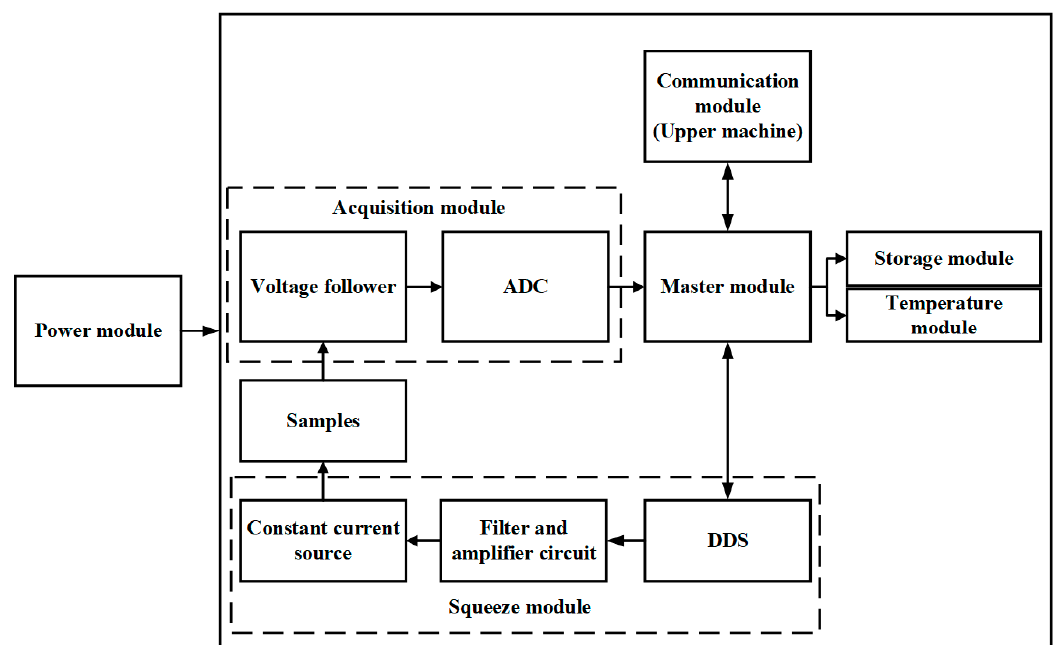
Figure 6. The overall hardware structure of the resistivity measurement system.